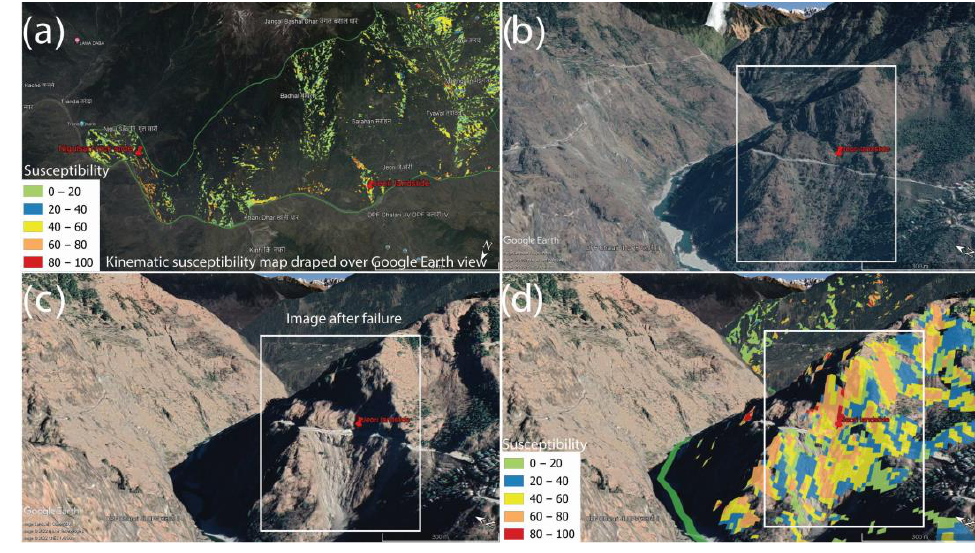
Figure 14. ( a ) Kinematic susceptibility map draped over Google Earth (GE) view showing locations of Nigulsari and Jeori landslide; ( b ) GE image before occurrence of Jeori landslide; ( c ) GE image post failure clearly shows signs of disturbance; ( d ) Susceptibility map overlain on GE view shows the zone is highly to very-highly susceptible to kinematic failure.